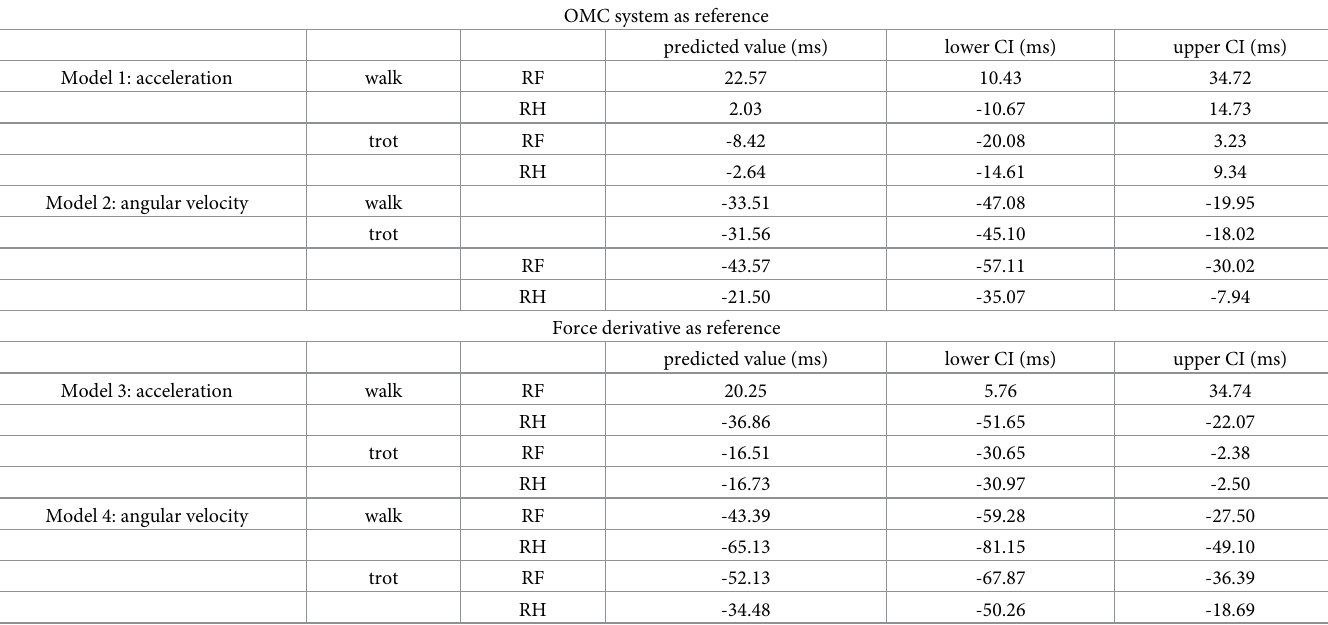
Table 1. Linear mixed model results for the acceleration and angular velocity